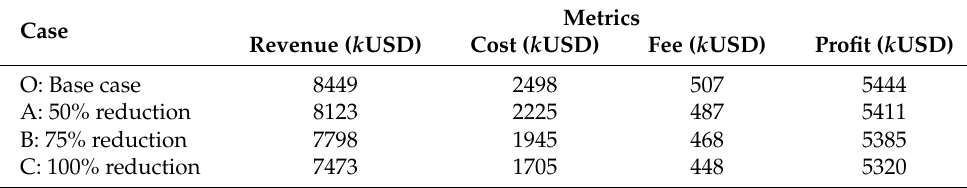
Table 9. General results for each hand-cracked capacity